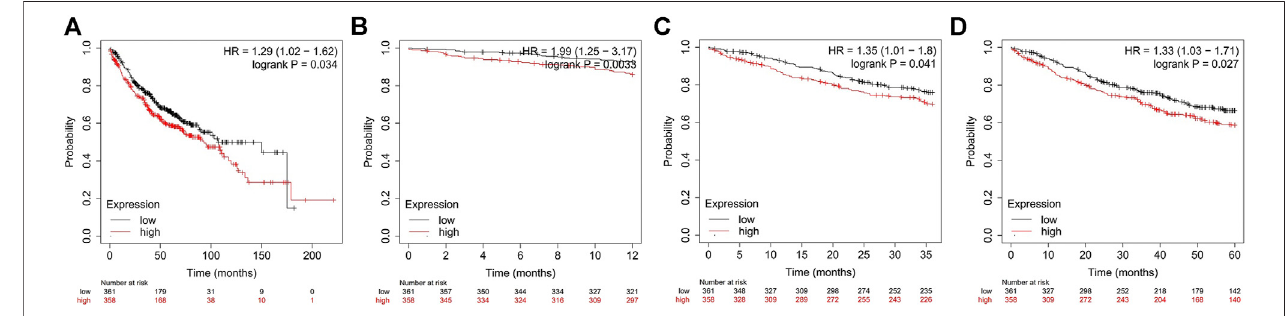
FIGURE4| Theexpressionof ADORA2B isassociatedwithLUADpatientsurvival. (A) MeanOSanalysisofLUADpatientswithhighandlow ADORA2B expression OS analysis of LUAD patients with high and low ADORA2B expressions for (B) 12 months (1 year), (C) 36 months (3 years), and (D) 60 months (5